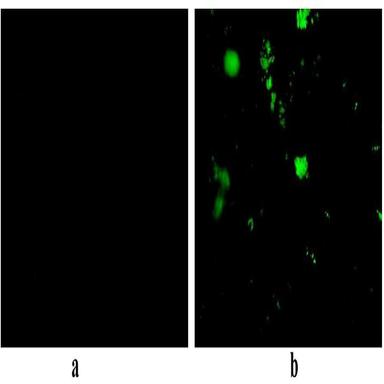
Fluorescence microscopy. a) hTF in the absence of MG not exhibiting green fluorescence. b) hTF after incubation with 50 mM MG exhibits green fluorescence with ThT suggesting the presence of aggregates.